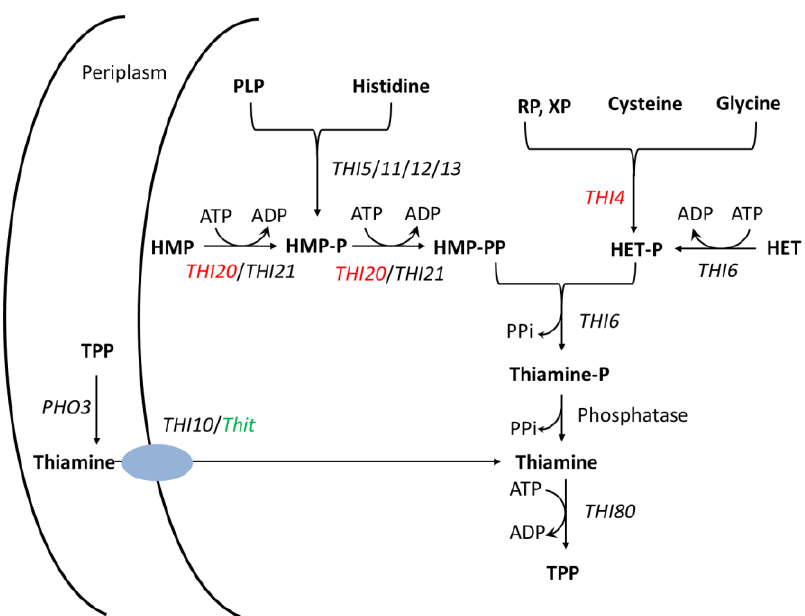
Figure 1. A schematic of the thiamine biosynthesis pathway. Black italics represent the genes found in S. cerevisiae . Green italics represent the genes found in V. dahliae . Red italics indicate genes found in both S. cerevisiae and V. dahliae . Blue oval represents thiamine transport protein.